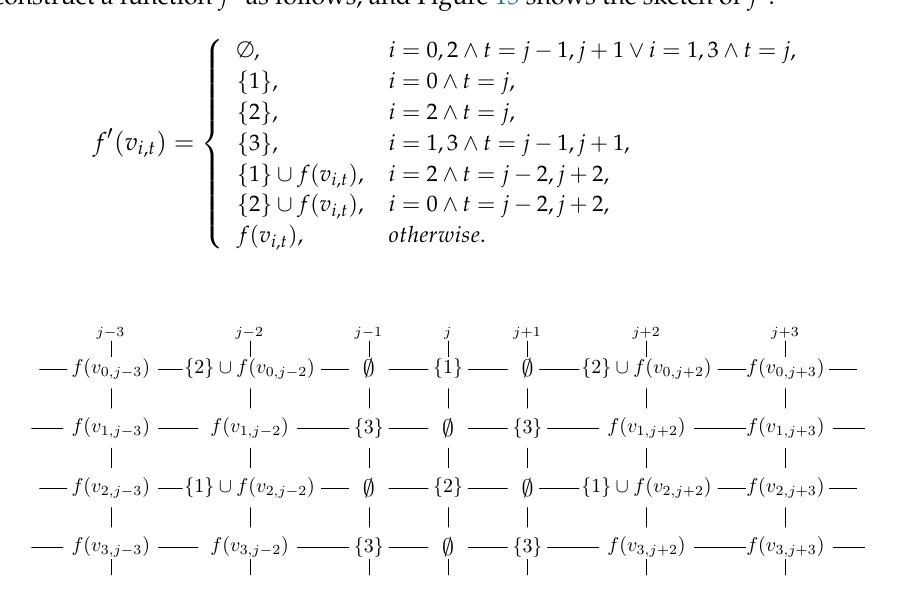
Figure 15. Sketch of f ′ Figure 15. The sketch of f (cid:48) in Lemma